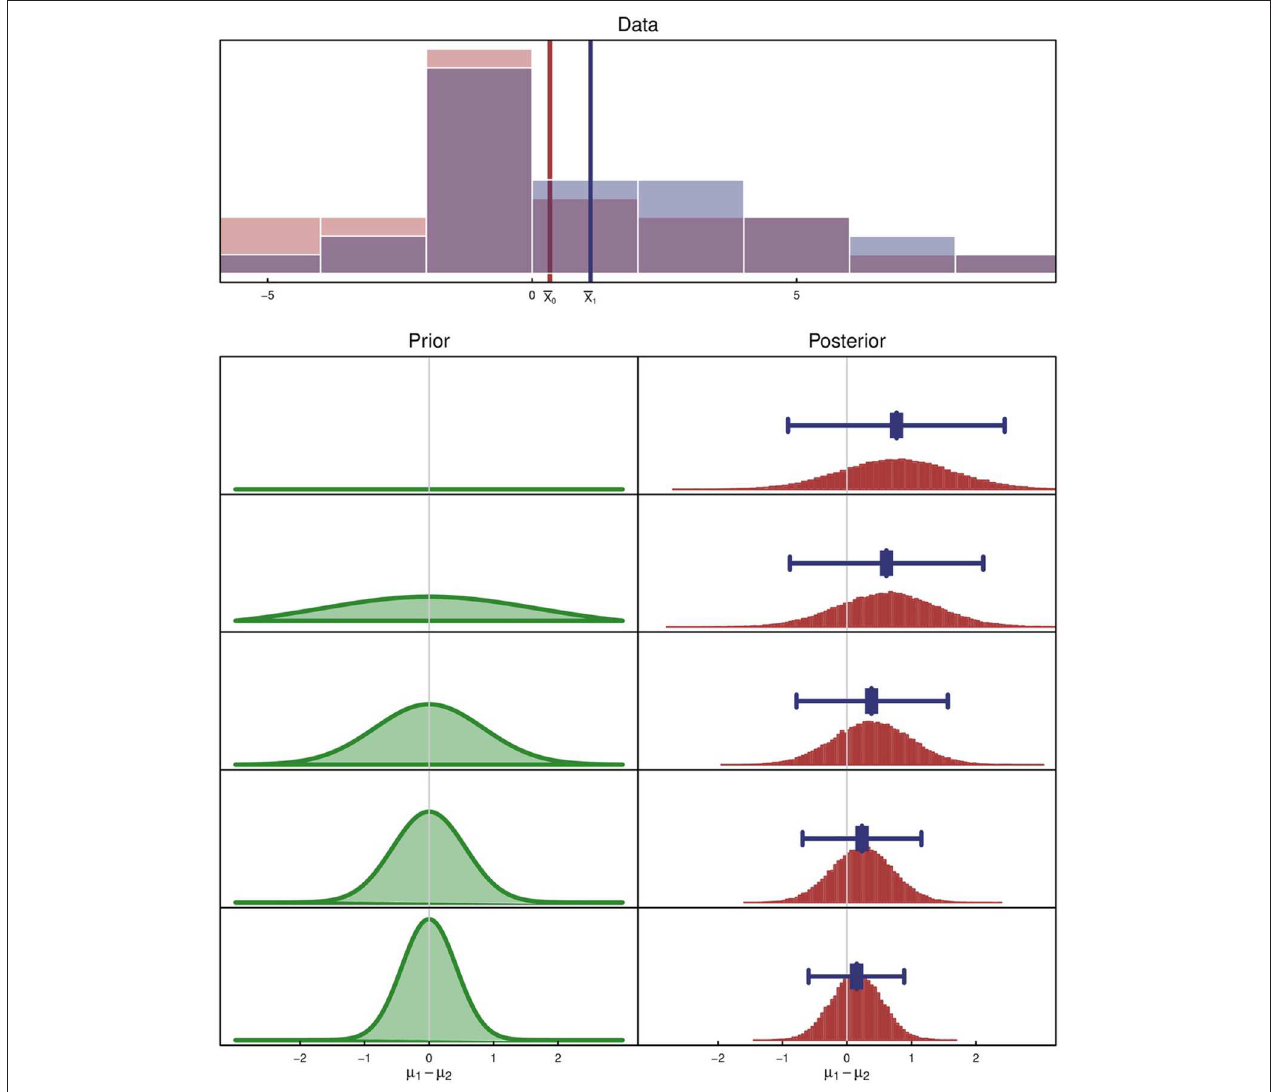
FIGURE 2 | An illustration of shrinkage when additional structure is incorporated into a model by regularization. In this illustration, regularization is achieved with a Bayesian prior, which ranges from flat to peaked. The top figure is the hypothetical data collected from two groups. N (per group) is 30. The observed sample means are shown as X 1 and X 0 . The bottom panel shows the posterior distributions (right column) resulting from the choice of prior for the difference in means (left column). As variation in the prior decreases, the resulting interval estimate and point estimate (shown as a blue line and point overlaid on the posterior) are shrunk toward